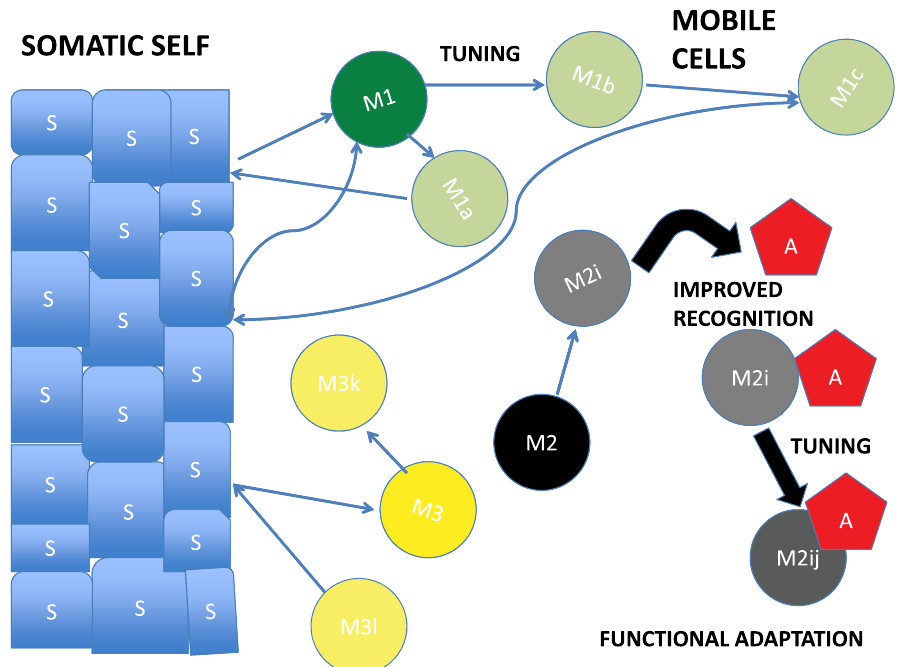
Figure 2. The normative self model. The left side shows maximization of diversity of mobile cells (M) under the control of somatic cells (S). Thanks to tuning, various M cells (M1, M2, M3…) (in green, yellow and black) undergo diversification into (M1a, M1b…), (M2i, M2j …), (M3k, M3n…) (same colors with small variations), through deformations of their internal networks. S cells cannot diversify much because they are in close permanent contact. Diversified M cells (such as M1a, M3k, M3n) are occasionally reset to the M1 and M3 states by contact with S cells. The right side shows an aberrant cell (A) (in red), which is either altered (cancer) or infected. Thanks to network deformations (tuning), the population of mobile cells is more diverse, and there is a higher probability that a cell (M2i) properly recognizes the aberrant cell A. The recognition may